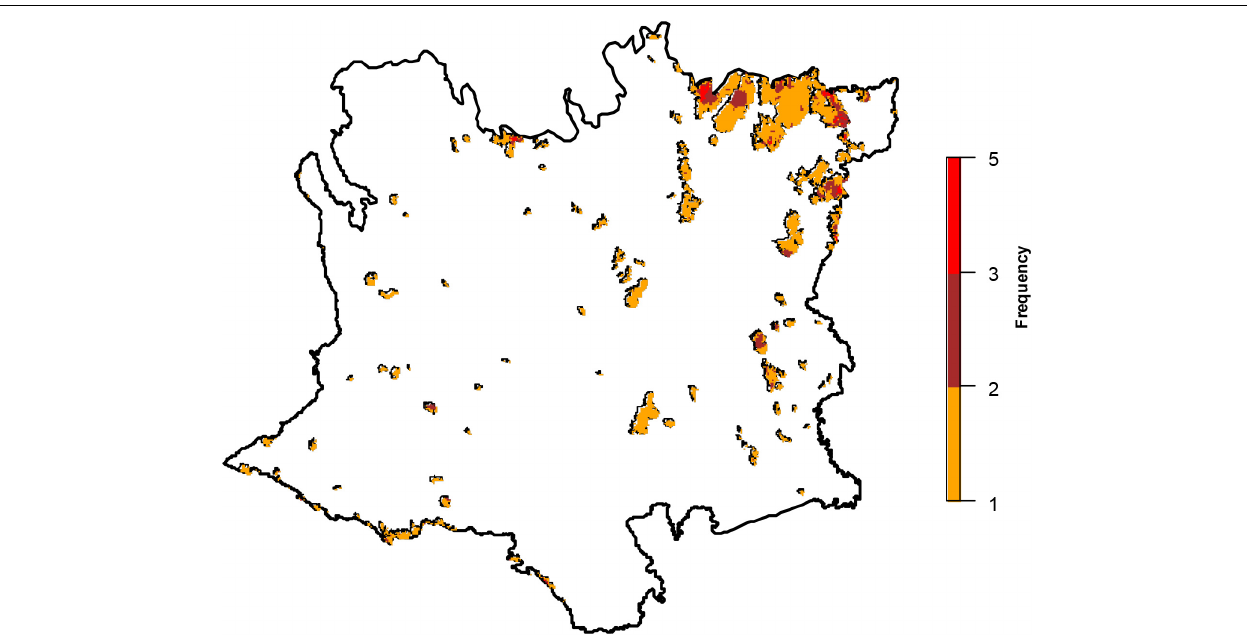
FIGURE 2 | Fire perimeters classified by fire frequency (number of times burned from 1972 to 2010; 1, 2, and > 2) for 250 fires > 405 ha in the Mojave Desert of North America.